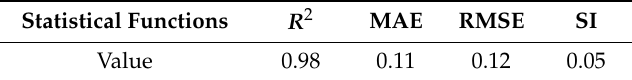
Figure 15. A comparison of simulated scour depth and corresponding experimental data. Table 4. Error analysis of CFD turbine scour model. MAE: mean absolute error; RMSE: root mean squared error; SI: scatter index.